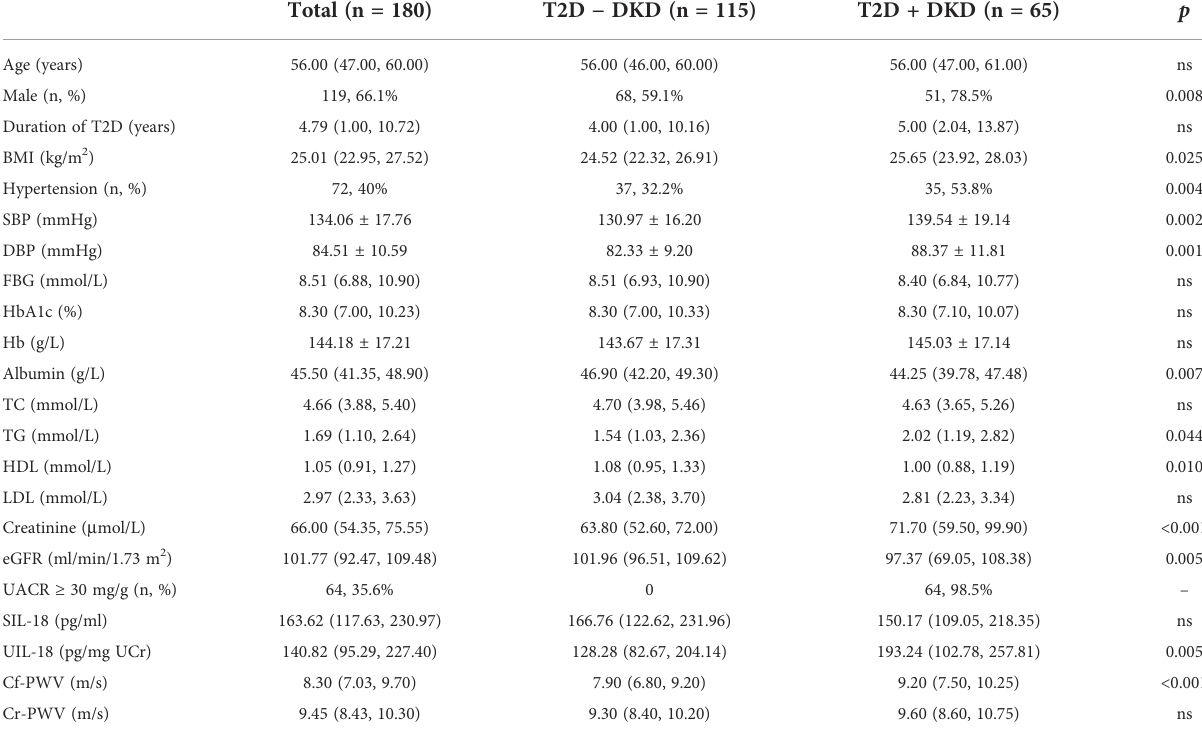
TABLE 1 Clinical characteristics of subjects with type 2